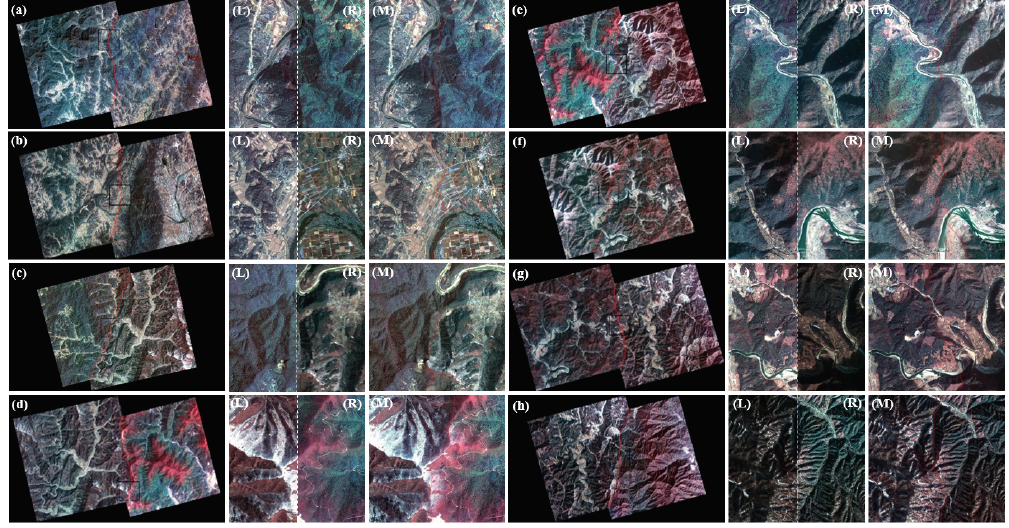
Figure 8. Final mosaic images for each pair of Kompsat-2 images. ( a ) Fall-Fall; ( b ) Spring-Spring; ( c ) Summer-Spring; ( d ) Spring-Spring; ( e ) Spring-Winter; ( f ) Winter-Spring; ( g ) Spring-Winter; ( h ) Winter-Fall.